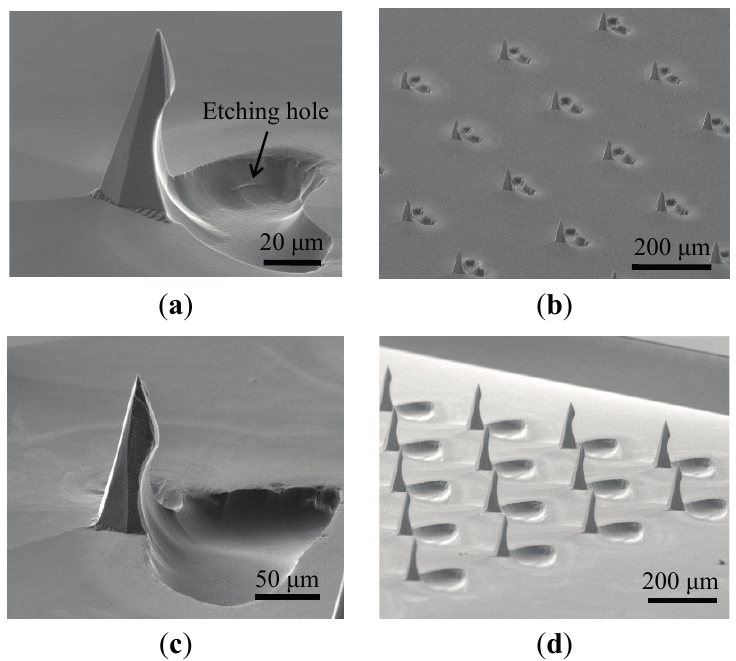
Figure 6. SEM images of the barbed microtips (array) after HF/HNO etching. ( a ) and ( b ) show the short barbed microtips (82 μ m); ( c ) and ( d ) show the long barbed microtips (155 μ m).